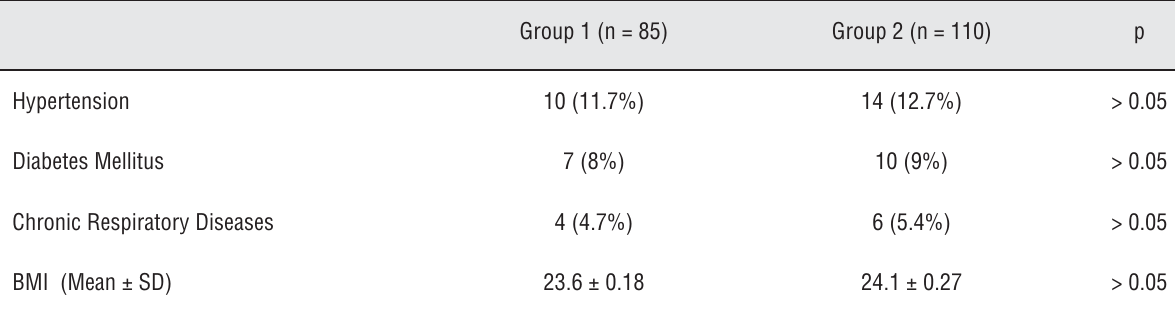
Table 1 - Co-morbidites and BMI of both